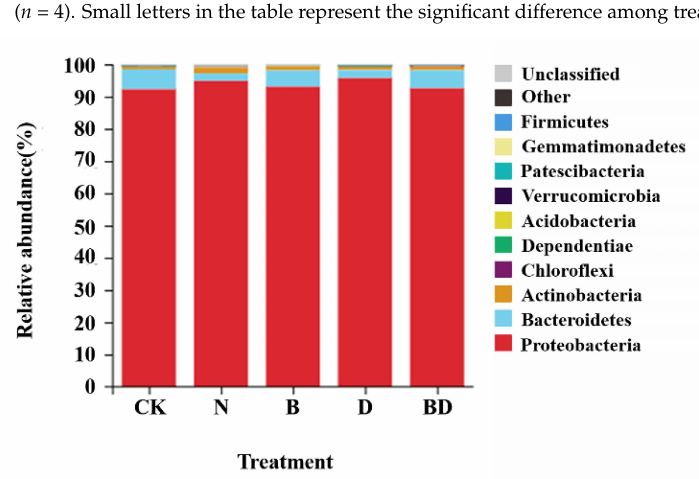
Figure 7. The relative abundance of phylum-level in soil